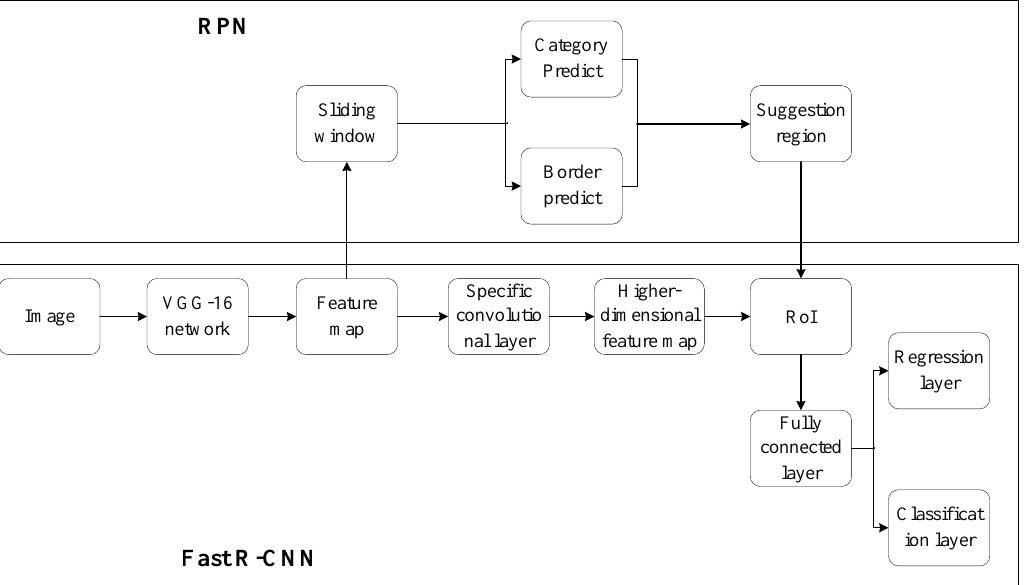
Figure 1. Faster region-based Convolutional Neural Network (R-CNN).